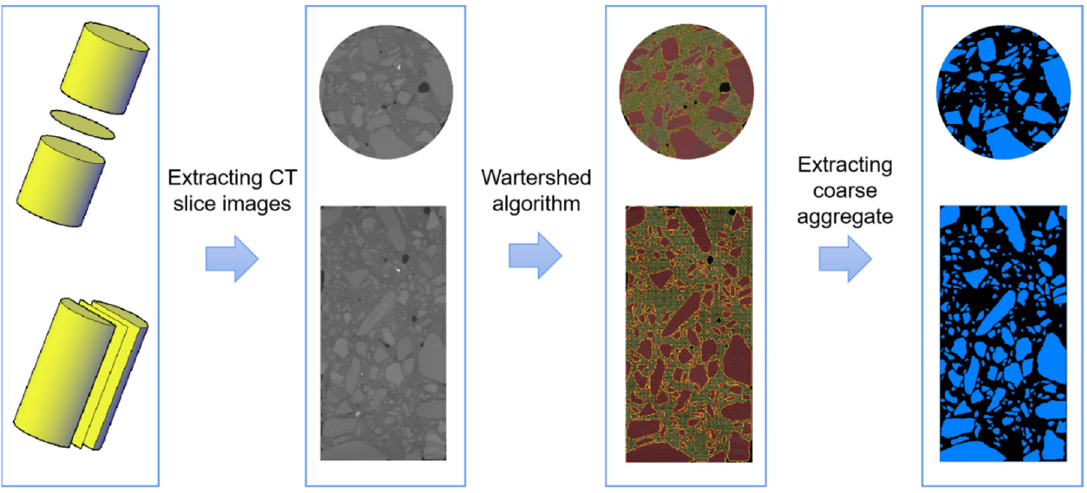
Figure 6. The extraction process of the coarse aggregate information corresponding to the ultrasonic survey line of the CT image.